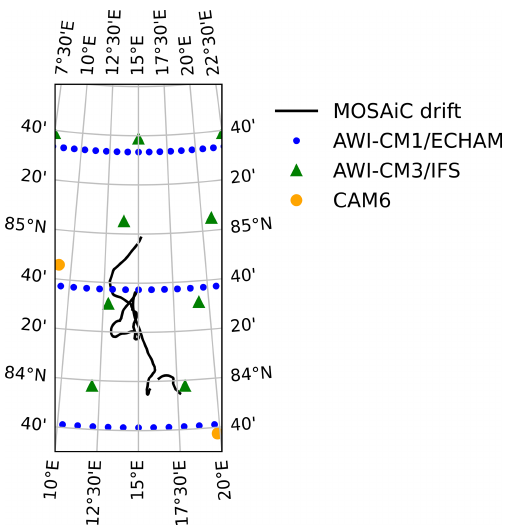
Figure 1. Drift of the MOSAiC central observatory during April 2020 and model grid points covering the area. The observatory is drifting